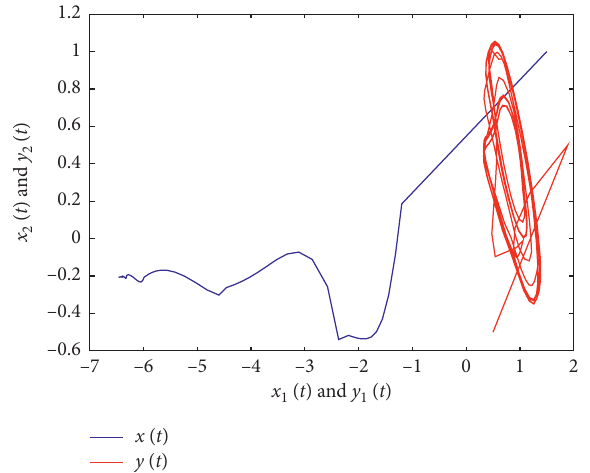
Figure 1: Chaotic attractor of the drive-response system when μ k � − 0 . 7.